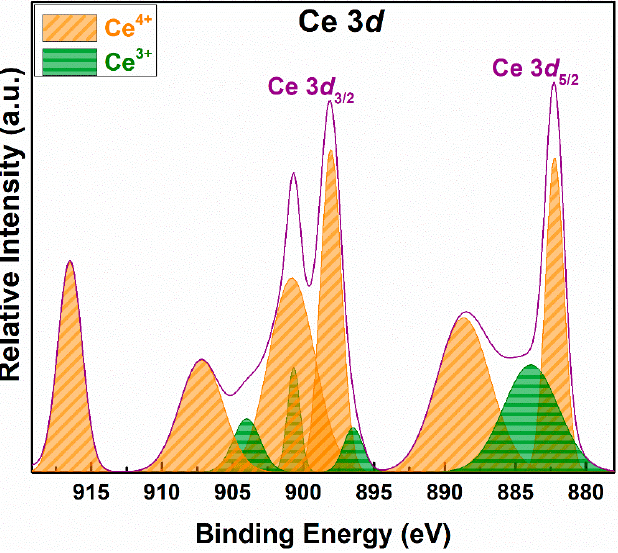
Figure 3. Deconvolution spectrum of Ce 3 d of the catalyst. Table 2. Deconvoluted XPS spectrum of Ce 3 d distribution in the catalyst.